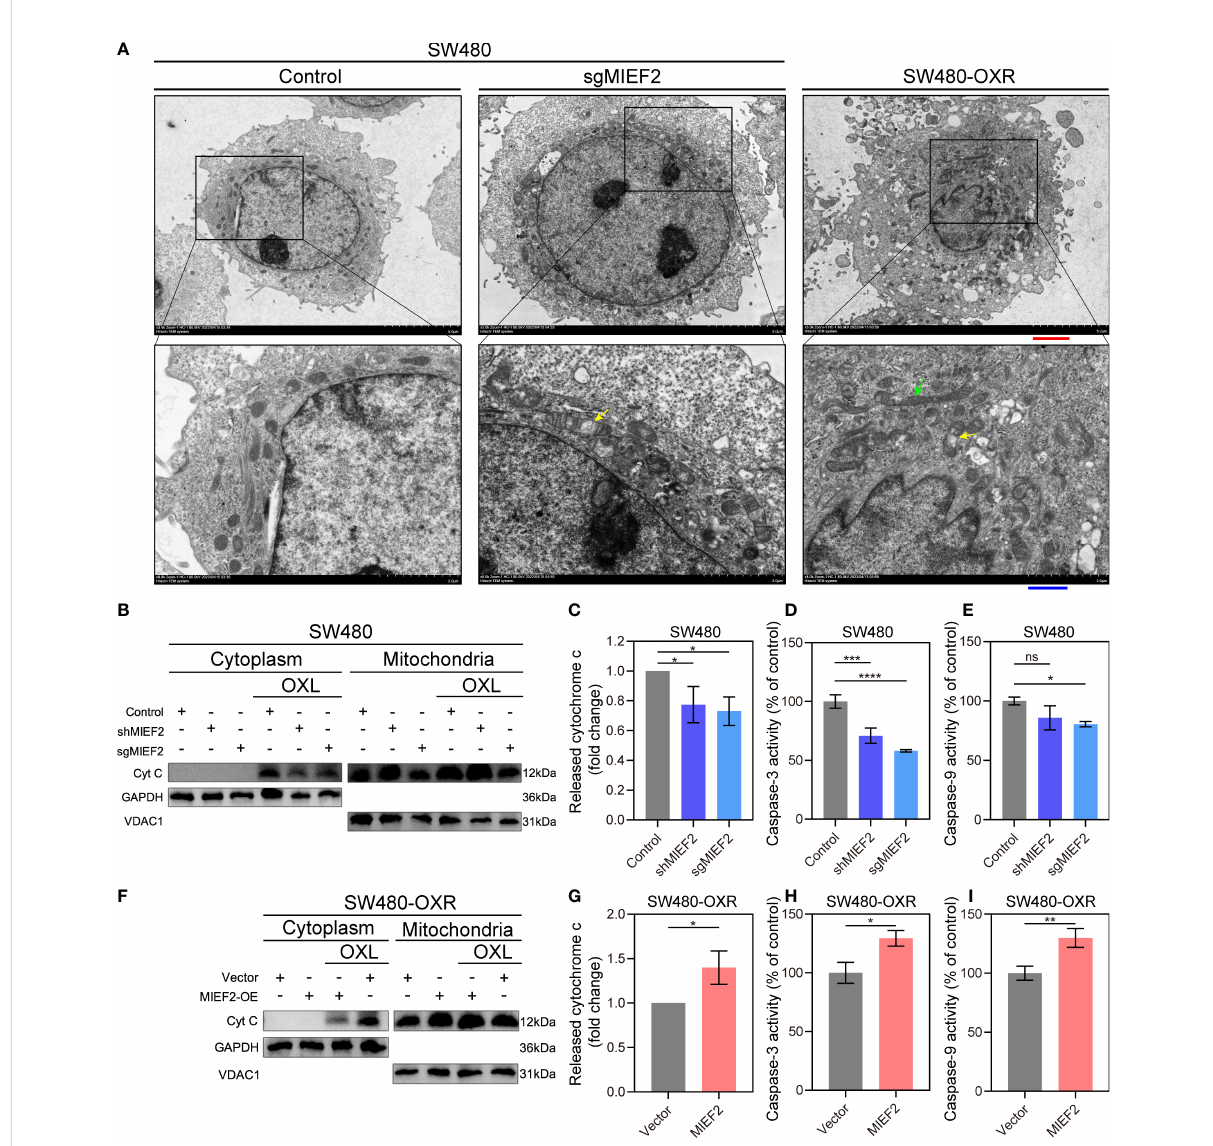
FIGURE 6 MIEF2 regulates the release of mitochondrial cytochrome c in response to OXL treatment. (A) Representative transmission electron microscopy images of mitochondrial in SW480 and SW480-OXR. Yellow arrowhead: mitochondrial swelling, green arrowhead: abnormal long mitochondria. Red scale bars, 2.5 m m. Blue scale bars, 1 m m. (B) After OXL treatment, cytoplasmic and mitochondrial fractions of SW480 were extracted and cytochrome c was detected by Western bolting. Grayscale analysis of cytochrome c content in the cytoplasm was performed to assess cytochrome c release (C) . In parallel, caspase- and -9 activity was assayed (D, E) . SW480-OXR with or without MIEF2 overexpression was treated with OXL and cytochrome c release was detected by Western bolting (F, G) , followed by caspase- and -9 activity using caspase-3/9 activity assay kits (H, I) . Bars represent mean ± SD, n = 3 repetitions. Statistical analysis was performed using two-tailed unpaired t-test. ns P < 0.05, *P < 0.05, **P < 0.01, ***P < 0.001, ****P <